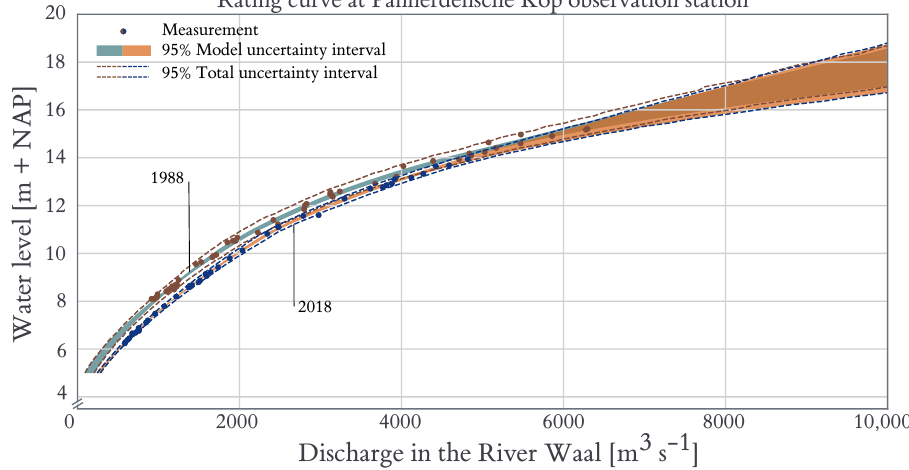
Figure 6. The rating curves constrained on available data for 1988 (blue shaded area) and 2018 (orange shaded area), showing overall lower water levels in 2018 for the same discharge.